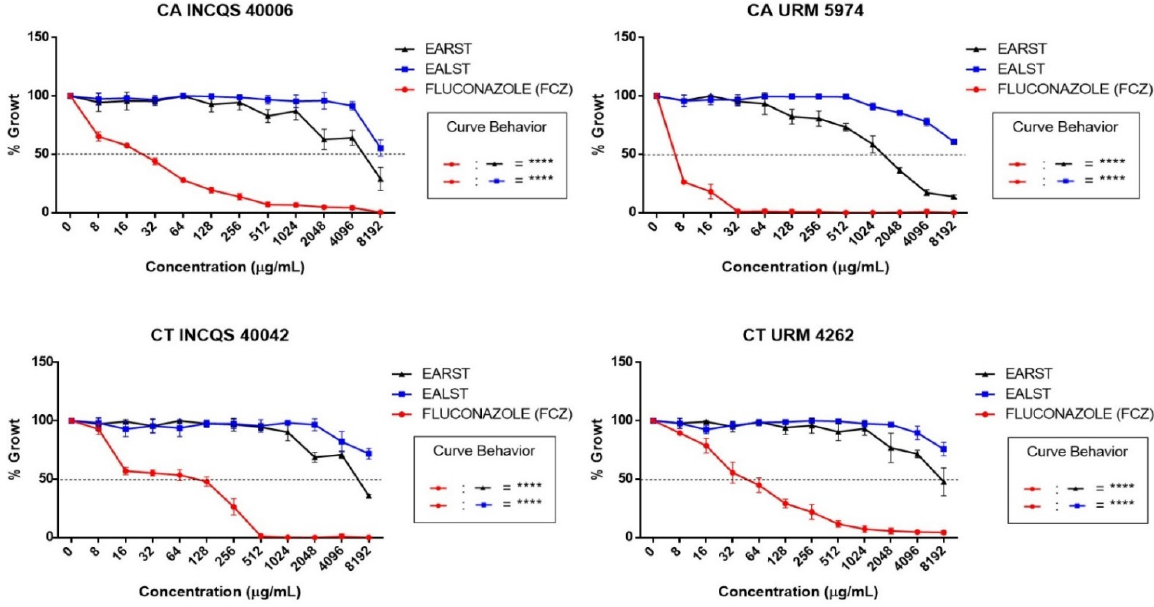
Figure 1. Cell viability curve of fluconazole and aqueous extracts of Spondias tuberosa against Candida strains . CA: Candida albicans ; CT: Candida tropicalis ; INCQS: National Institute of Quality Control in